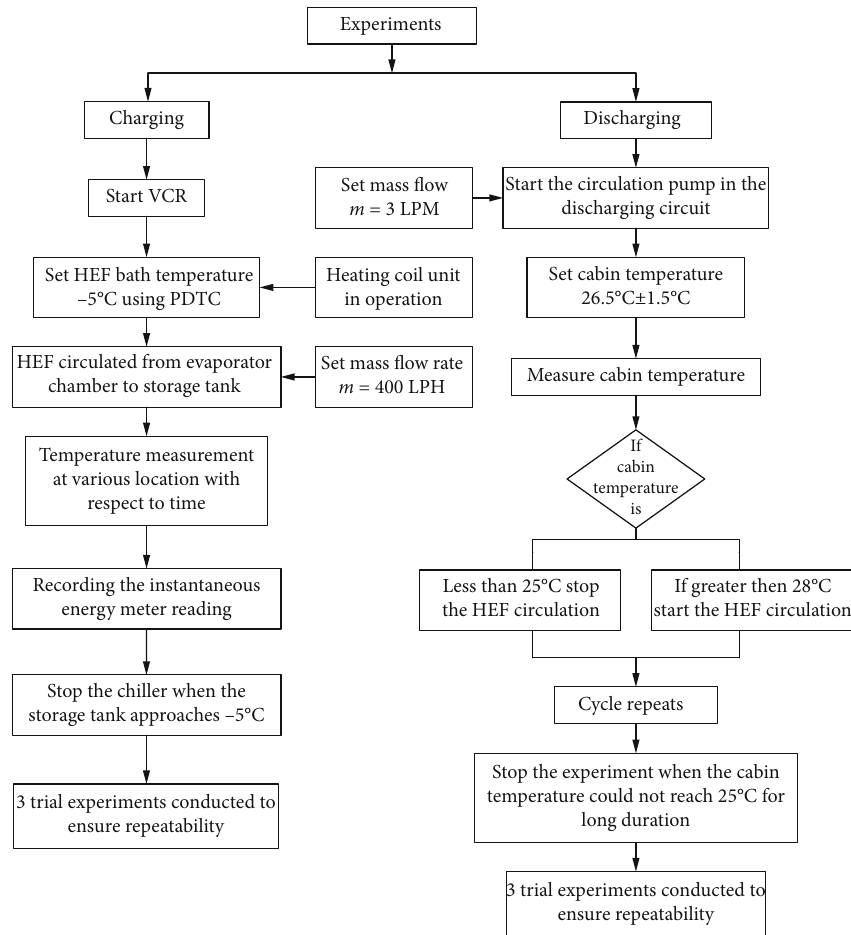
Figure 3: Methodology adopted for the experimental